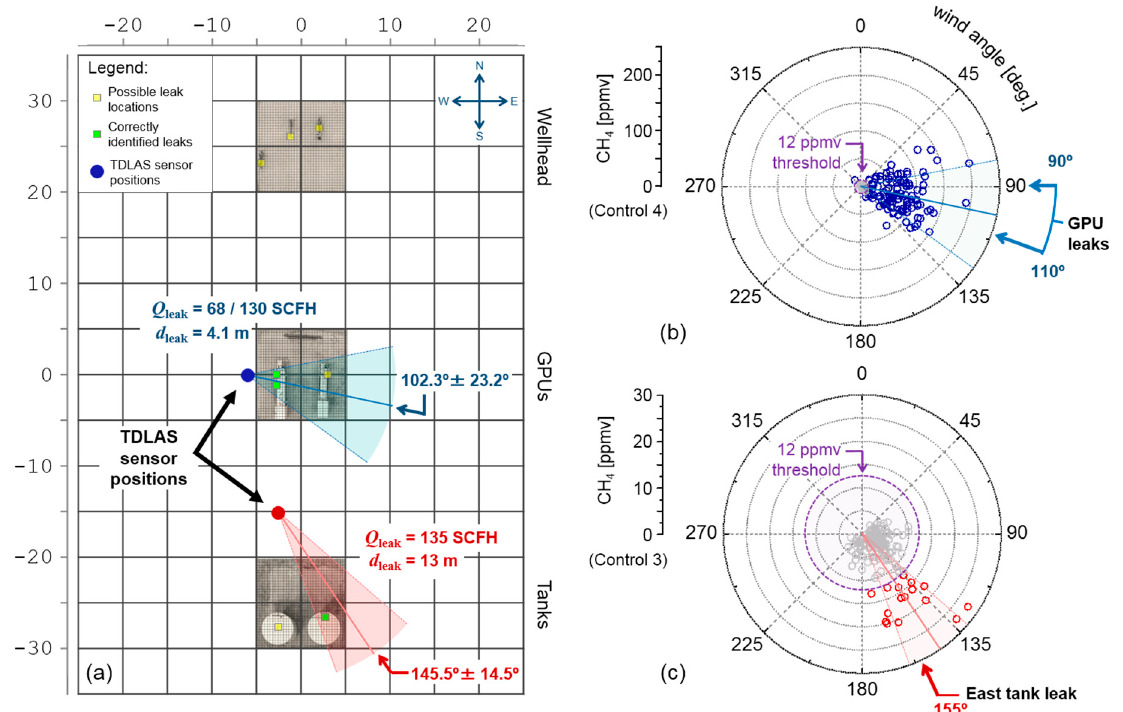
Figure 8. ( a ) Site layout for the experiments shown in Figure 6 (horizontal / vertical scale bar in meters). The source angle for the two depicted release experiments (blue and red) are determined using a concentration weighted average wind angle, shown in ( b ) and ( c ) respectively. The errors are correspondingly calculated using a weighted variance of wind angles from the mean. To ensure accurate AOA retrieval, signal thresholding ([CH 4 ] thresh = 12 ppmv) was used to eliminate erroneous peaks resulting from noise offsets in the CH 4 baseline.